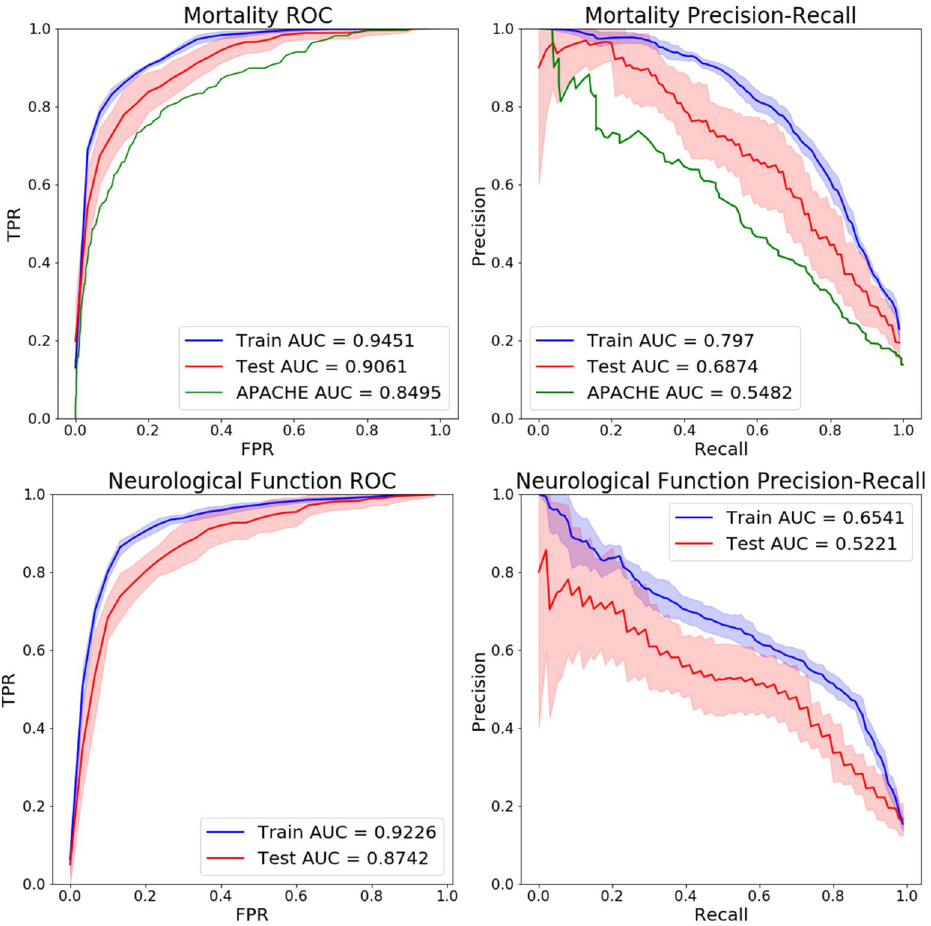
Figure 2. Receiver operating characteristic and precision recall curves. The blue lines and red lines correspond to results on the training sets and testing sets respectively, with the shaded error corresponding to the standard deviation across the 20 bootstrapped train-test splits. The green lines correspond to the existing APACHE-IV mortality prediction model evaluated on the eICU patients. ROC, Receiver operating characteristic. AUC area under the curve, TPR true positive rate, FPR false positive rate, GCS Glasgow Coma